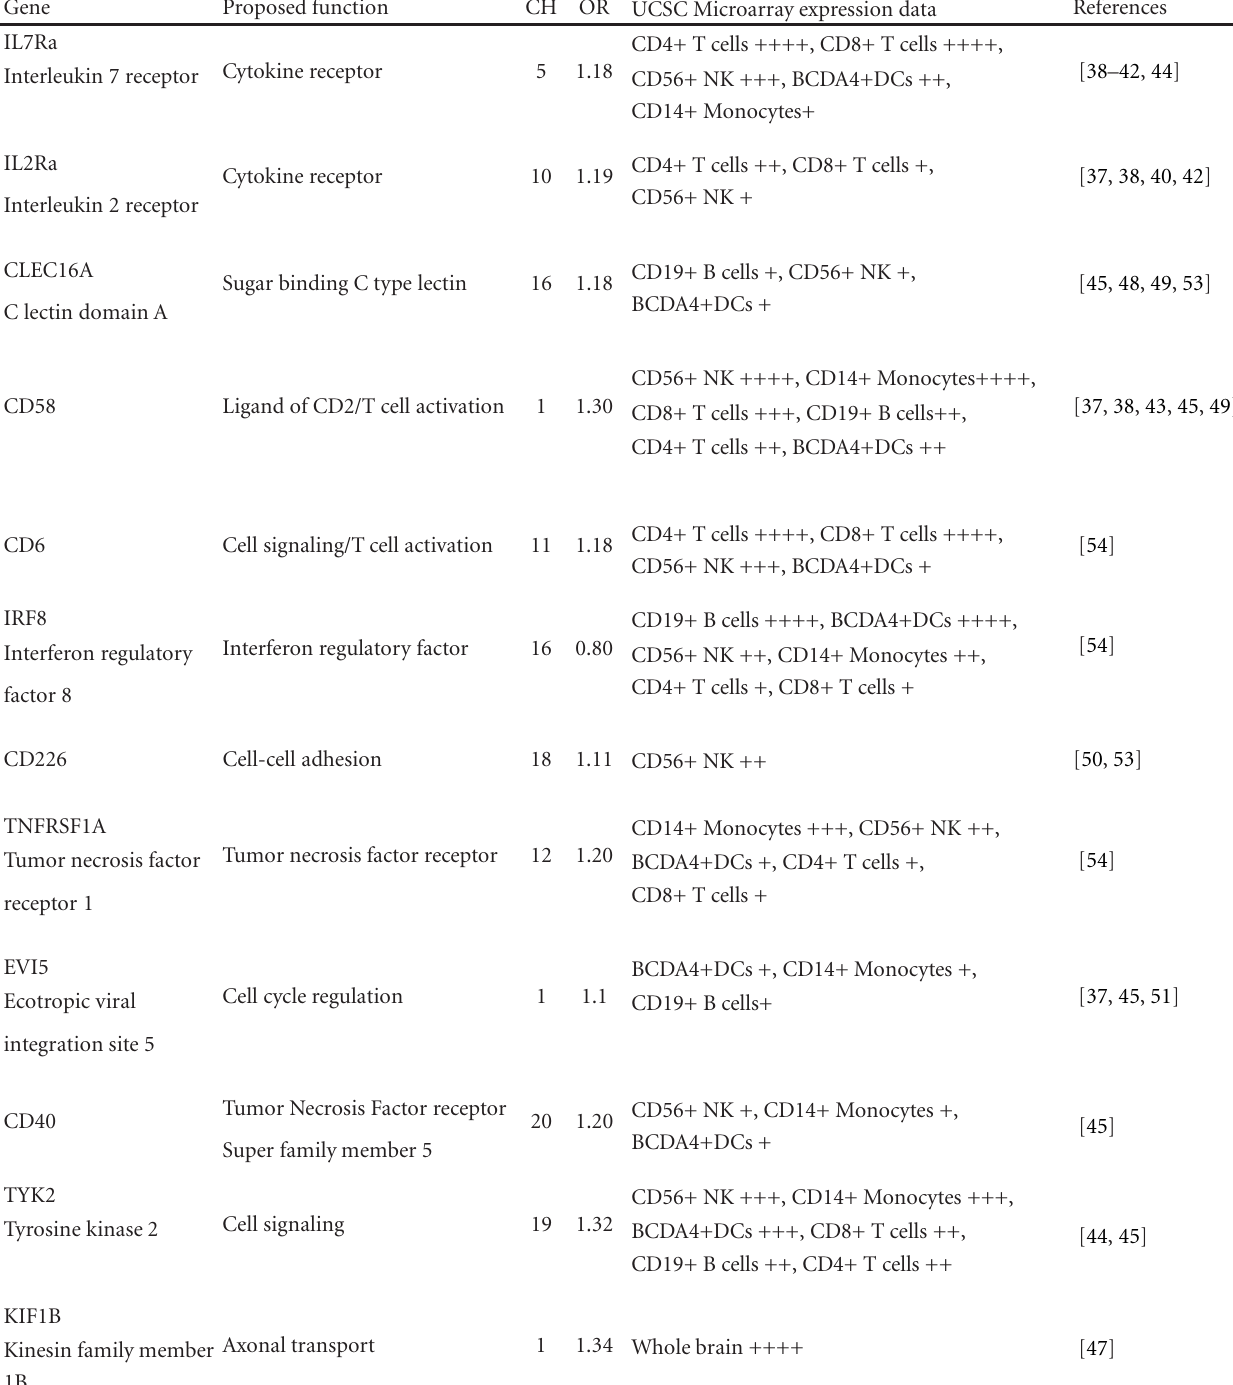
Table 3: List of established non-MHC MS-associated